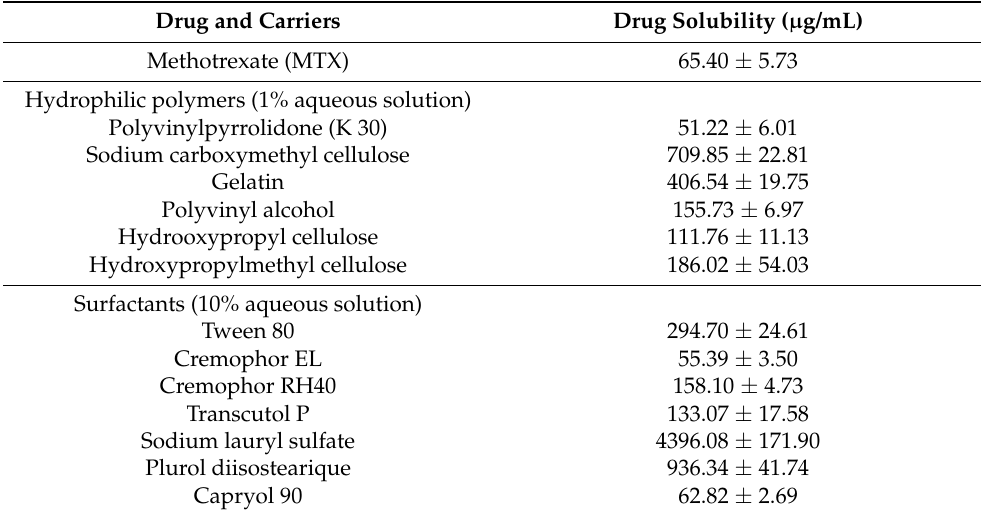
Table 2. Effect of carriers on the drug solubility. Each value represents the mean ± SD ( n = 3). Drug and Carriers Drug Solubility ( µ